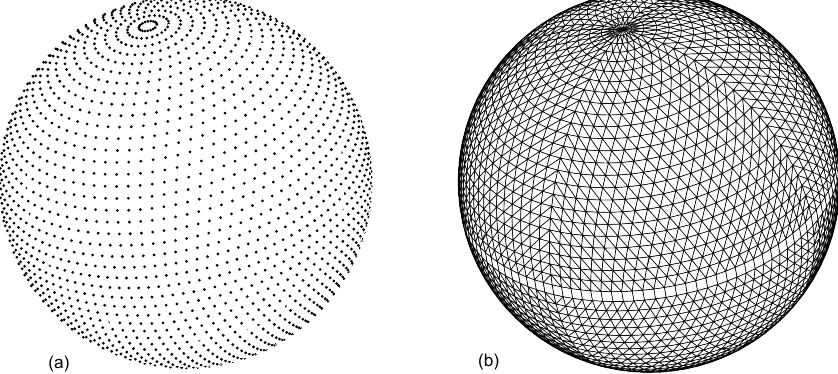
Figure 4. Locations of the octahedral reduced Gaussian grid nodes (a) , and the edges of the primary mesh connecting the nodes as applied with the finite-volume discretisation in FVM (b) . A coarse octahedral grid with only 24 latitudes between each pole and the Equator (“O24”) is used for illustration. The dual mesh resolution of the octahedral reduced Gaussian grid is about a factor of 2 finer at the poles than at the Equator; see Smolarkiewicz et al.